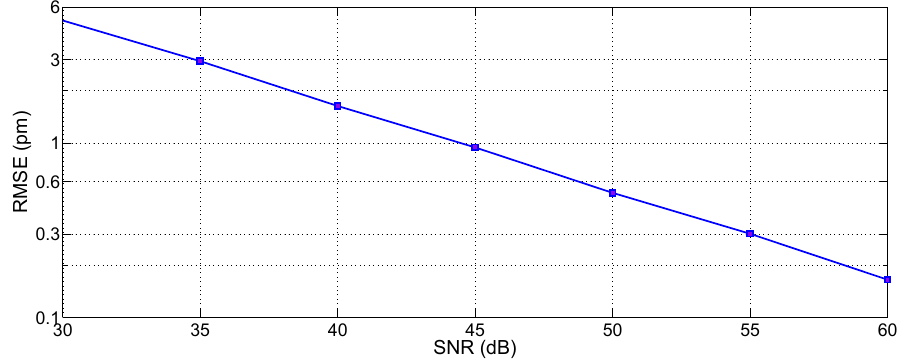
Figure 26. Performance analysis of KLT tracking technique: the RMSE on peak detection is reported as a function of SNR, for coarse grid ( δλ = 156 pm).